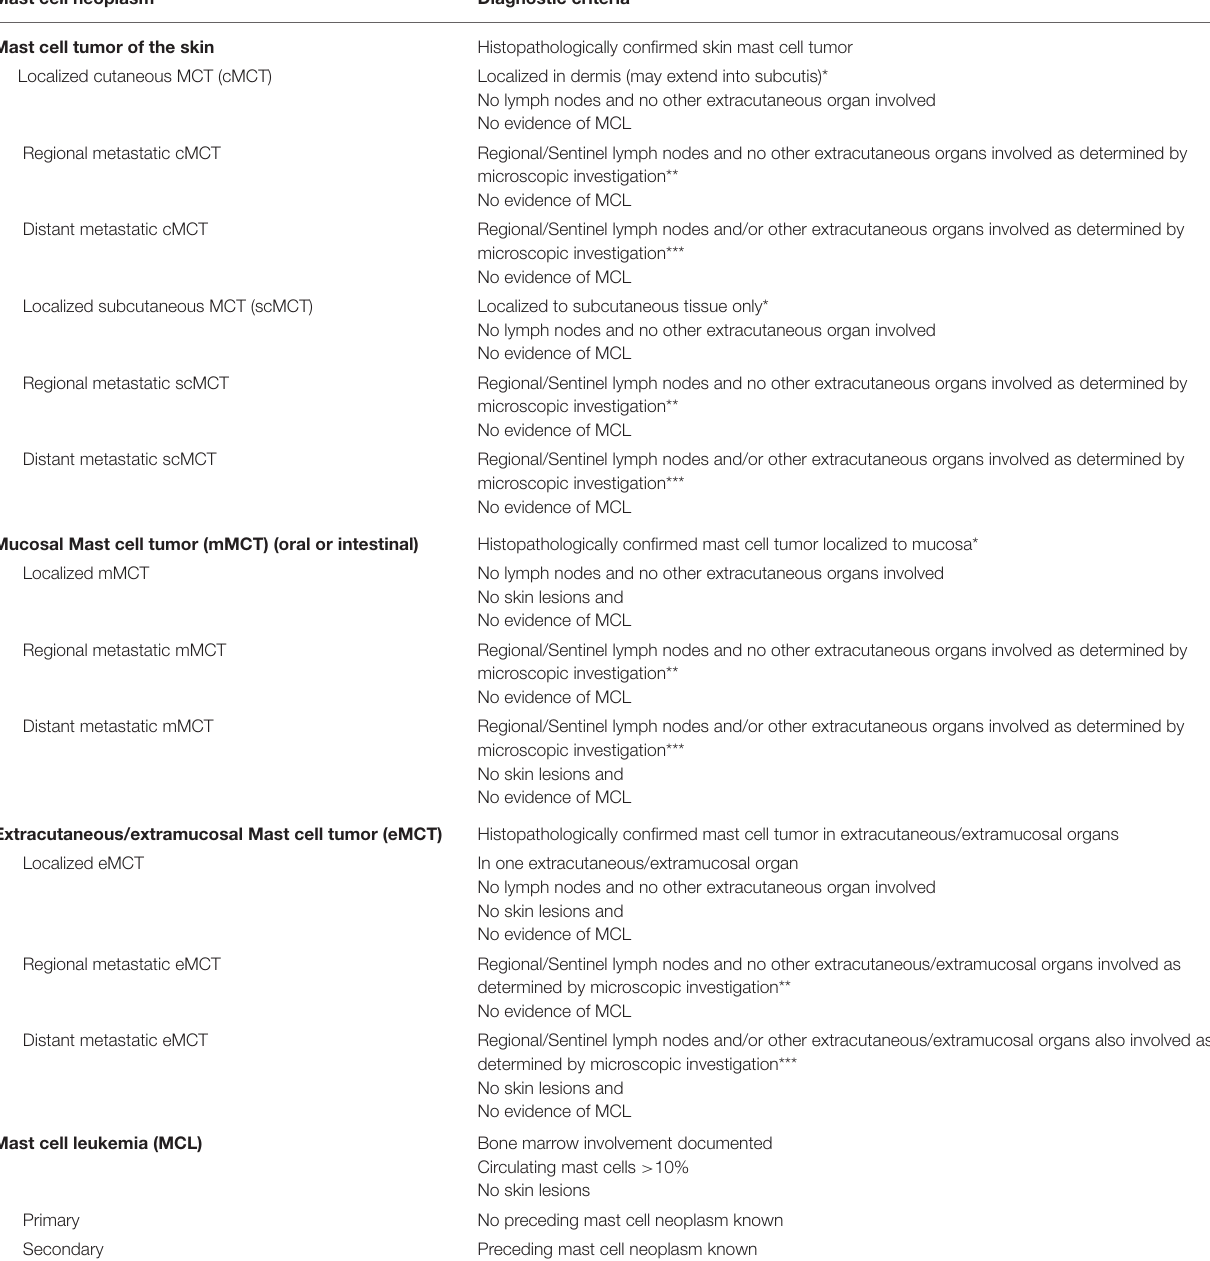
TABLE 1 | Proposed classification of canine mast cell neoplasms. Mast cell neoplasm Diagnostic